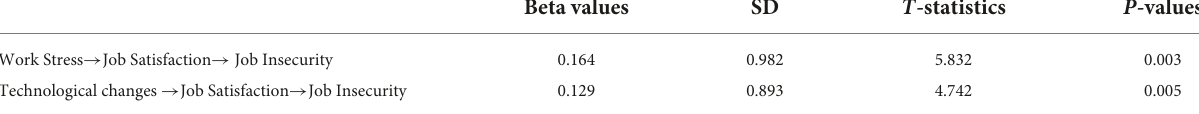
TABLE 7 Mediation analysis (indirect